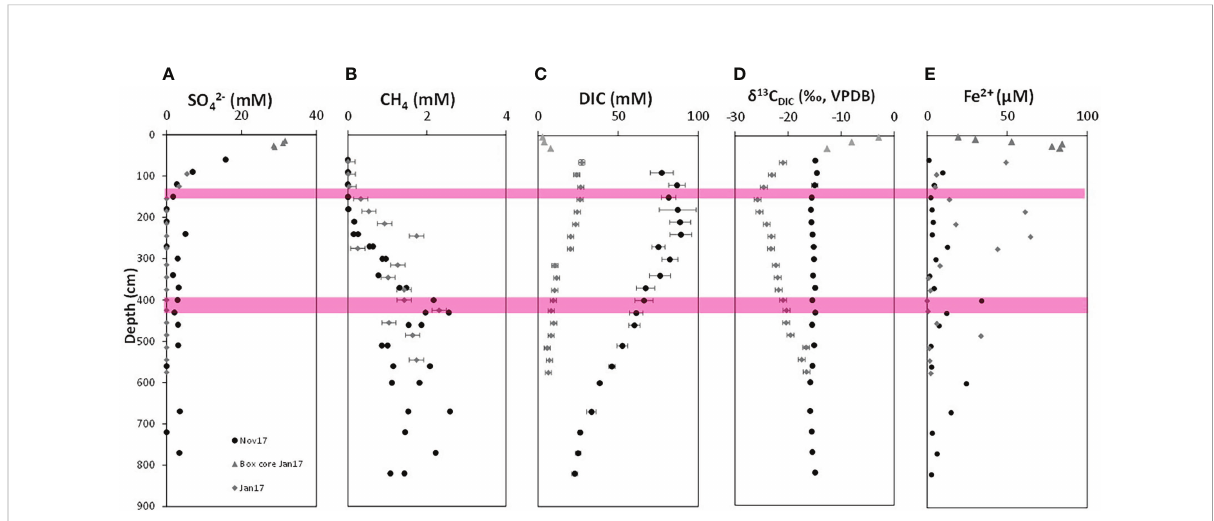
FIGURE 2 Depth pro fi les of dissolved geochemical species from SG-1 station from January and November 2017. (A) Sulfate concentrations. (B) Methane concentrations. (C) DIC concentrations. (D) d 13 C DIC . (E) dissolved Fe 2+ concentrations. The locations of the sediments taken for the incubations are marked in red: The SMTZ in January 2017 (for experiment MS) and the deep methanic iron-rich zone in November 2017 (for experiment MD). Both duplicates are presented when measured. The analytical error is marked if larger than the